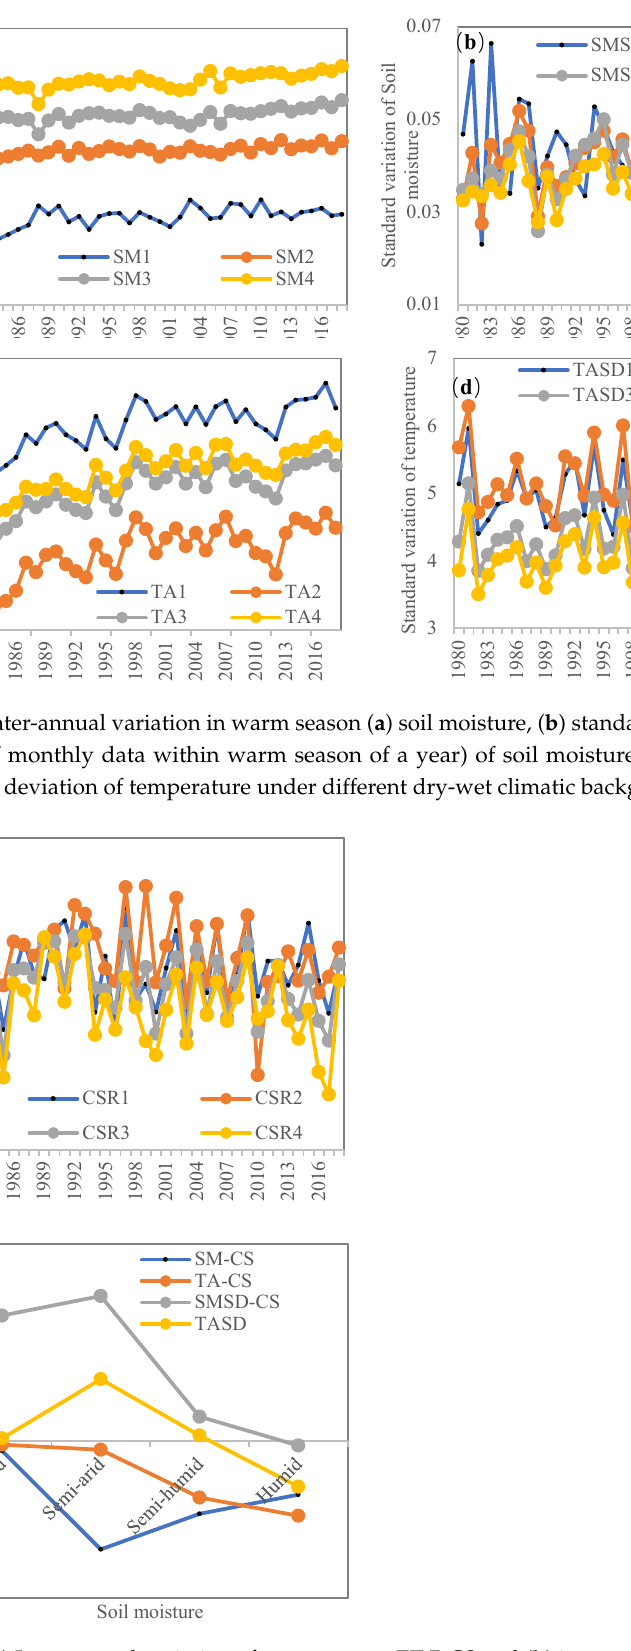
Figure 14. ( a ) Inter-annual variation of warm season ET-P CS and ( b ) its correlation coefficients with soil moisture (SM), standard deviation of soil moisture (SMCD), air temperature (TA) and standard deviation of temperature (TASD) under different dry-wet climatic conditions.